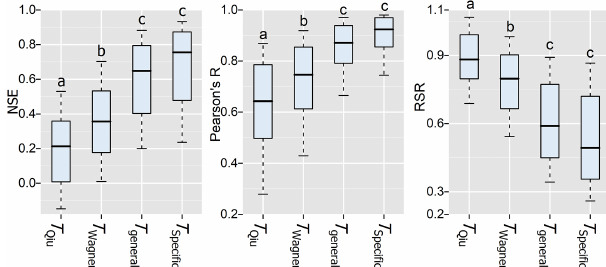
Figure 5. The boxplot of NSE, Pearson’s R , and RSR for the T opt generated from different schemes. The different letters above each box indicate the significant difference for different schemes.